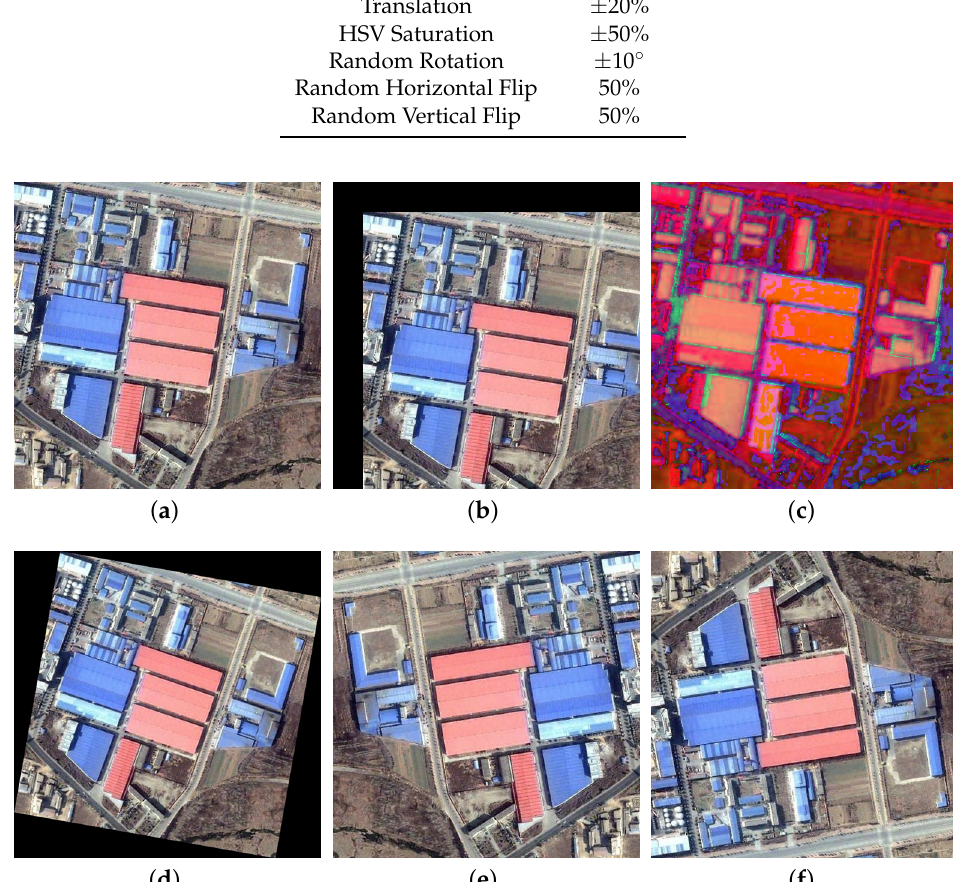
Figure 10. Diagrams of different data augmentation methods. ( a ) The original image; ( b ) the original image after being translated; panel ( c ) is the HSV transformed image; ( d ) the original image rotated by 10 degrees; panels ( e ) and ( f ) are images after horizontal and vertical rotation,